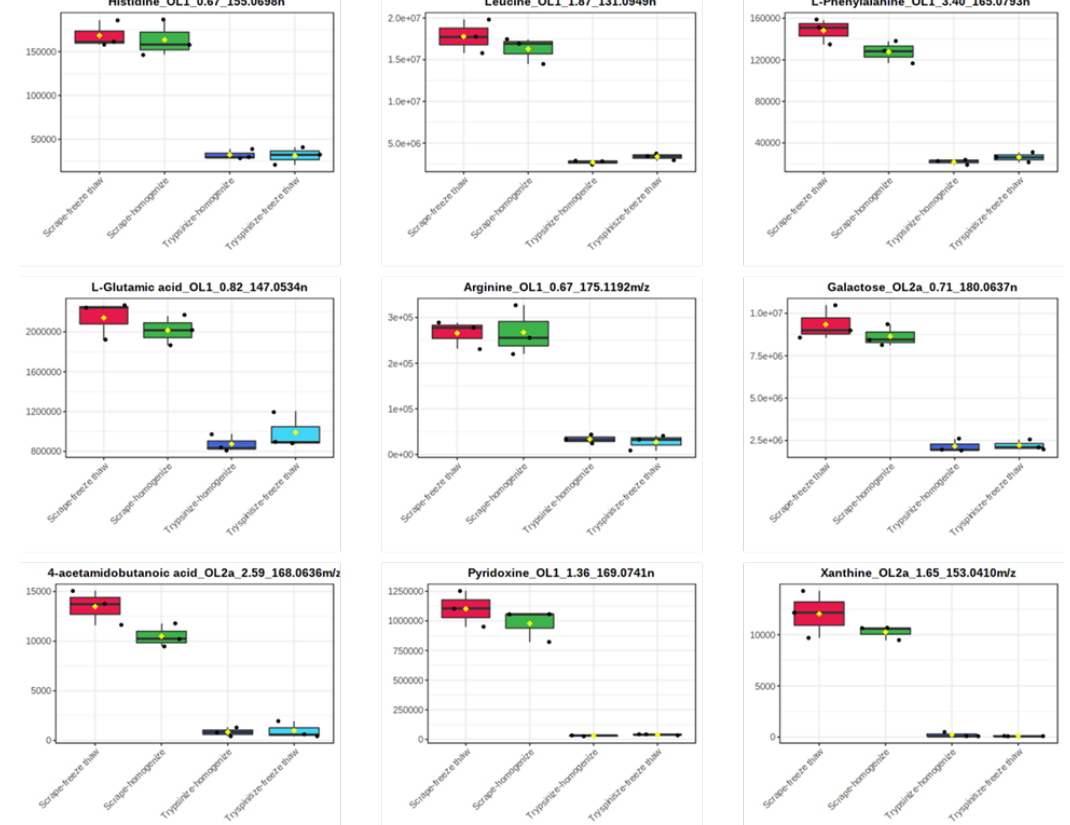
Figure 7. Representative metabolites that were increased in the scraped samples. Metabolites are displayed in the following format: compound name_ontology level_retention time_mass. Masses ending with n are neutral masses whereas masses ending in m / z are ion masses.